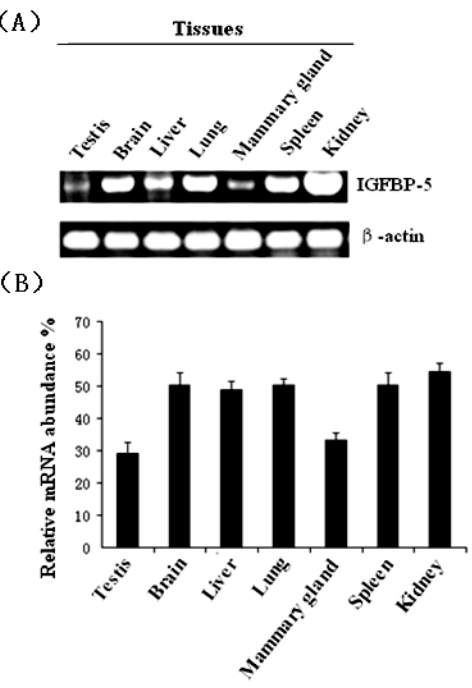
Figure 4. Expression of IGFBP-5 gene in different tissues. (A) Semi-quantitative RT-PCR detection of IGFBP-5 transcripts with  -actin mRNA as a loading control. (B) The band using gel was analyzed by BandScan software version